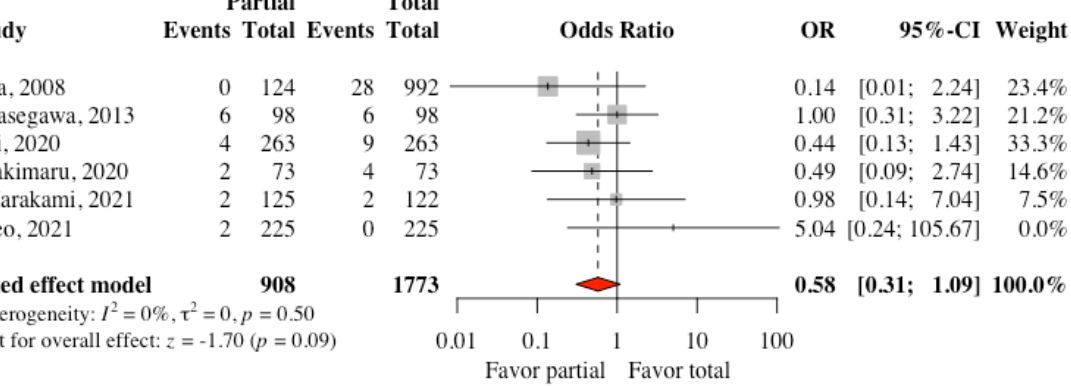
Figure 4. Forest plot comparing adhesion- and ileus-related complications incidence between the partial omentectomy and the total omentectomy groups.